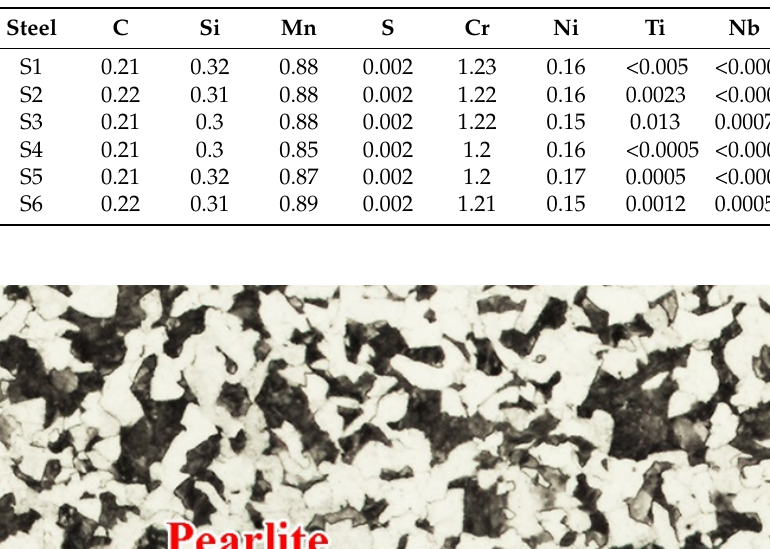
Table 1. Chemical compositions of the experimental steels (wt.%).